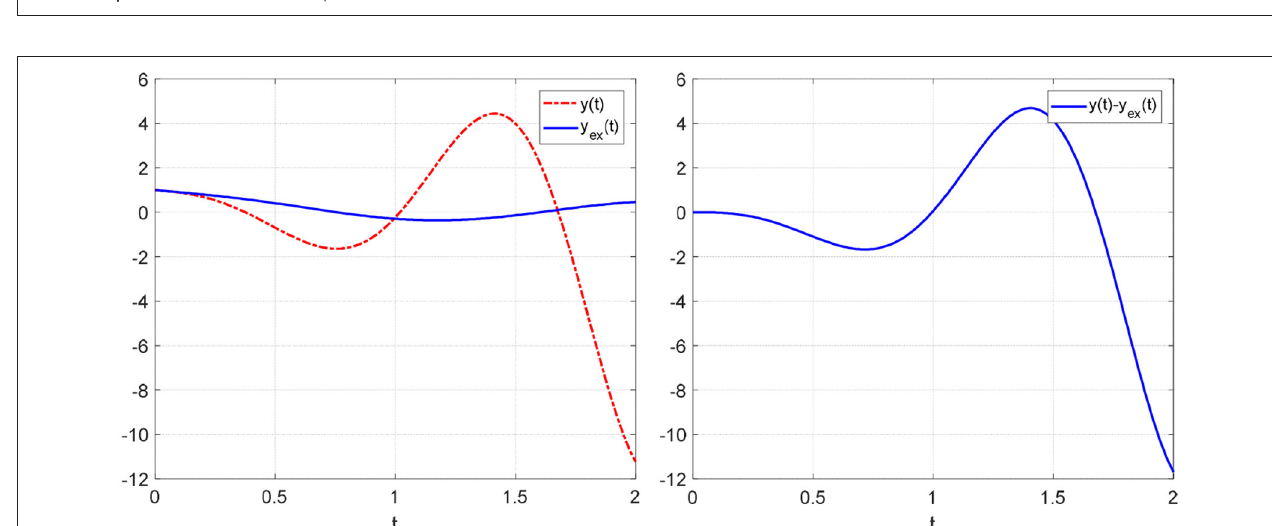
FIGURE 4 | Solution and error in Example 4.